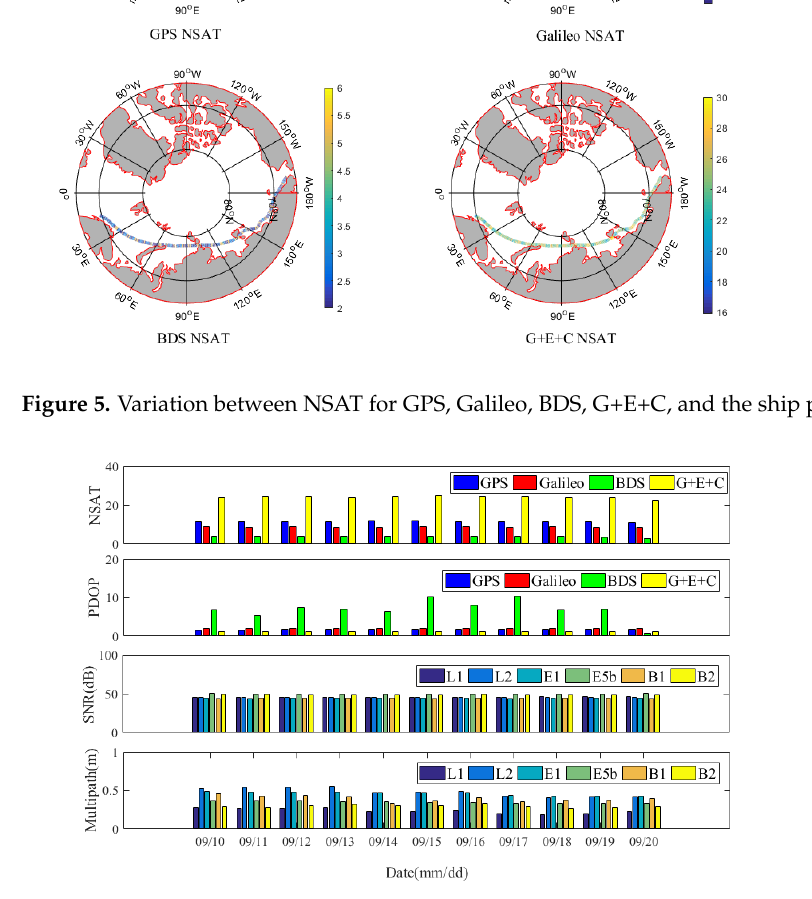
Figure 6. Daily average NSAT, PDOP, SNR, and multipath errors for GPS, Galileo, and BDS,